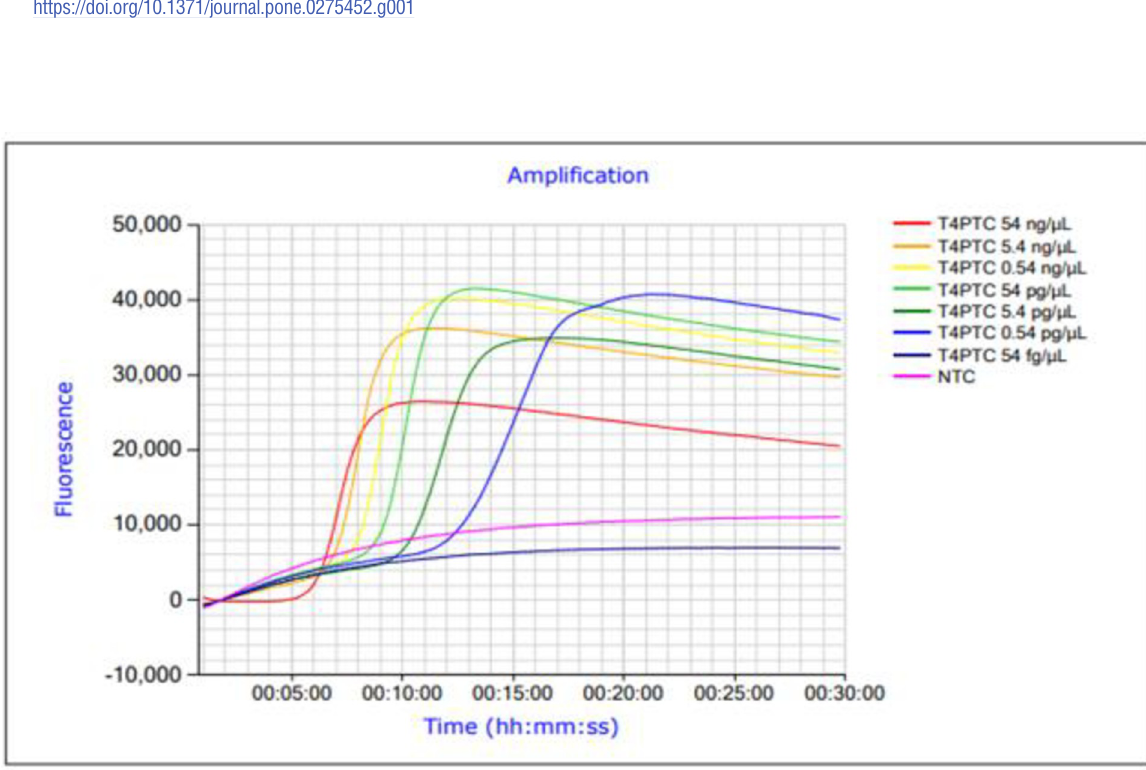
PLOS ONE | https://doi.org/10.1371/journal.pone.0275452 October 12, 2022 7 /